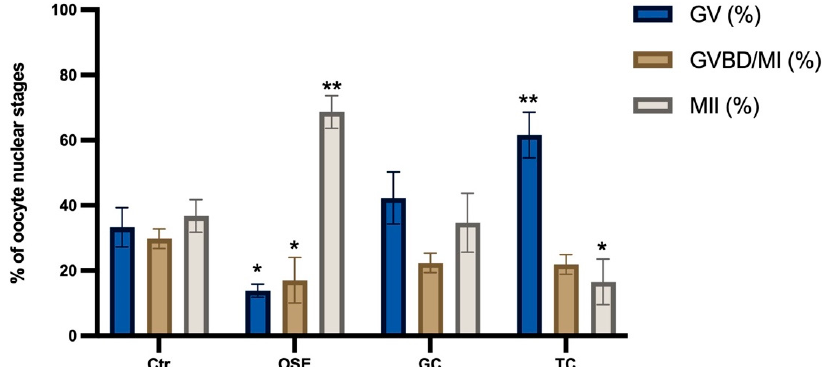
Figure 6. Influence of somatic cell cocultures on EA-FEO maturation protocol. The EA-FEO were induced to mature with hCG (25 IU/mL) in the absence (Ctr) or presence of primary cell monolayers. The used ovine cell typologies were: ovarian surface epithelial cells (OSE), granulosa cells (GC), or tenocytes (TC). Three independent biological replicates were performed for each tested experimental group (total number of oocytes analyzed: 131, 126, 129, and 128, respectively, for Ctr, OSE, GC, and TC). The significance of nuclear stage data ( p < 0.05) was analyzed vs. Ctr (hCG without cells) and indicated with (*) or (**) for p < 0.05 and p < 0.01 superscripts, respectively. the MII rate over the Ctr condition (MII: 68.7% OSE vs. 36.8% Ctr; p < 0.01) and over both GC and TC co-cultural groups (34.7% and 16.5%: for both p < 0.01 vs. OSE coculture group). Of note, TC exerted a clear adverse e ff ect by inhibiting the triggering hCG